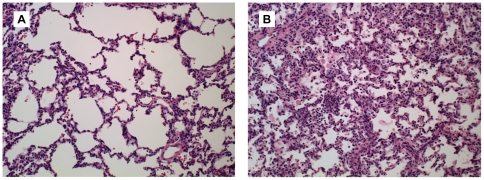
Uterine activity and amniotic fluid cytokines.Temporal relationships among inoculation of GBS or saline, uterine activity, and amniotic fluid (AF) cytokines (TNF-α, IL-8) are shown in a representative animal after saline inoculation (A) and in an animal after GBS inoculation (B), which developed moderate lung injury in the setting of minimal uterine activity. The x-axis represents gestational age in days ranging from the vascular implantation surgery until cesarean section. The y-axis is hourly contraction area (HCA; gray bars), or the level of amniotic fluid TNF-α (red line) or IL-8 (blue line). CD, choriodecidual; AF, amniotic fluid.